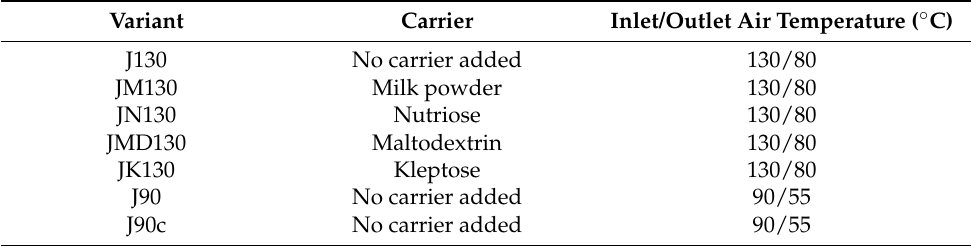
Table 1. Variants of cloudy beetroot juice spray-dried with or without carriers at different temperatures.